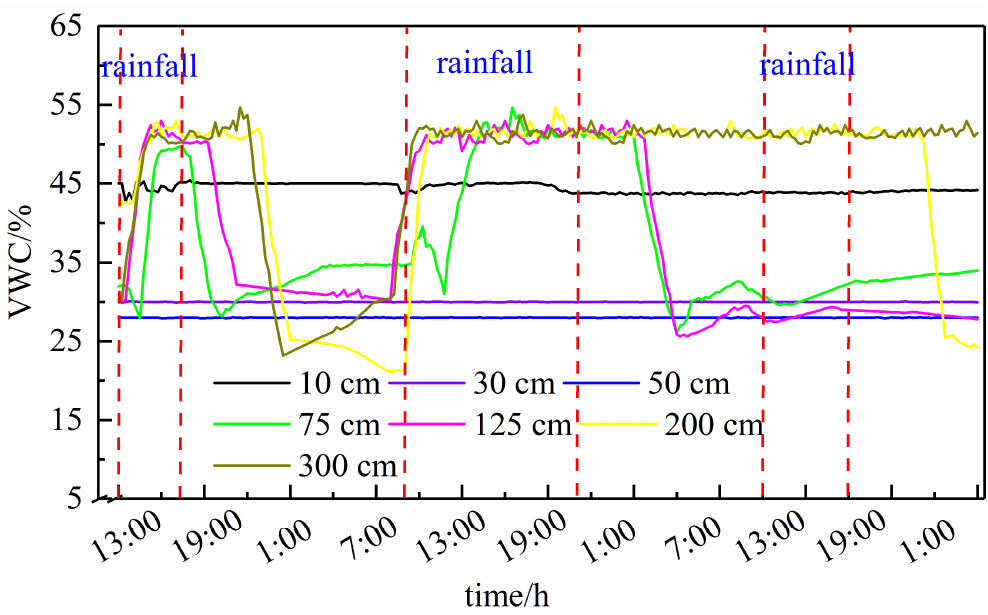
Figure 7. Time-varying curves of the volumetric water content under the second condition.